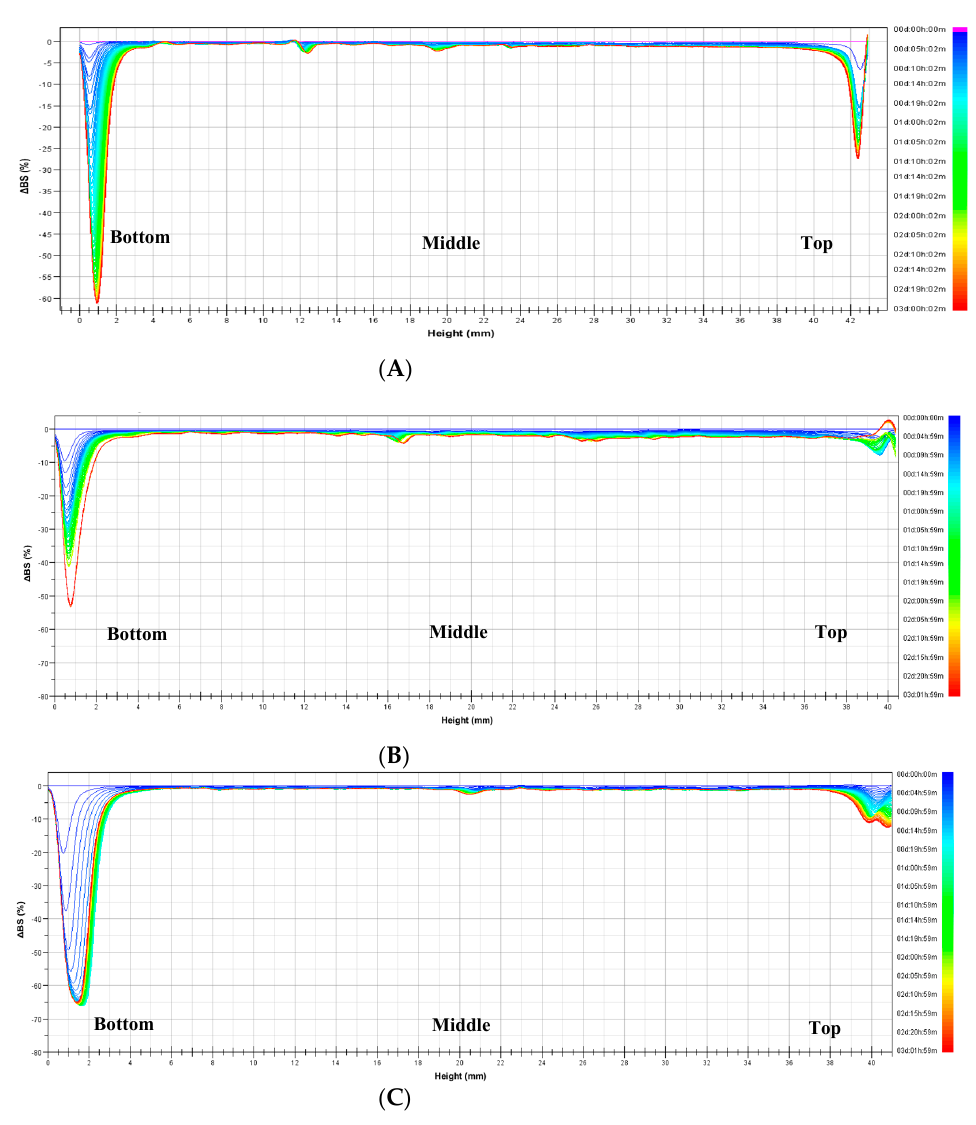
Figure 2. Delta backscattering ( ∆ BS) of the emulsion from ( A ) yellow soybean powder (YSP), ( B ) chickpea powder (CHP), and ( C ) egg white powder (EWP).